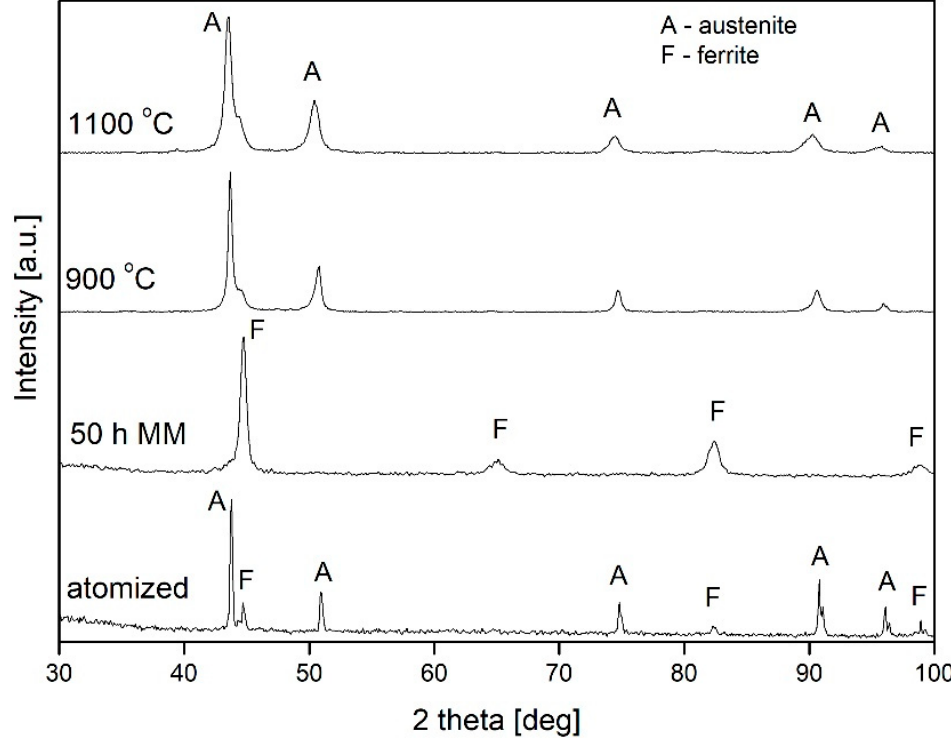
Figure 5. XRD patterns recorded for the atomized and milled powders as well as for sinters. XRD studies show that the patterns for sintered samples qualitatively are very similar to the one recorded for atomized powder, i.e., the diffraction lines of austenite are clearly visible, with some participation of ferrite in the structure. The contribution of ferrite is calculated as 12%. Simultaneously, the registered diffraction lines are broadened compared to starting powder. The crystallite size of austenite, calculated by Scherrer method, is about 20 nm ( ± 3 nm) for both compacts. The calculated value of austenite lattice parameter for the sample sintered at 900 ◦ C was 3.597 ± 0.005 Å, i.e., very close to the value for